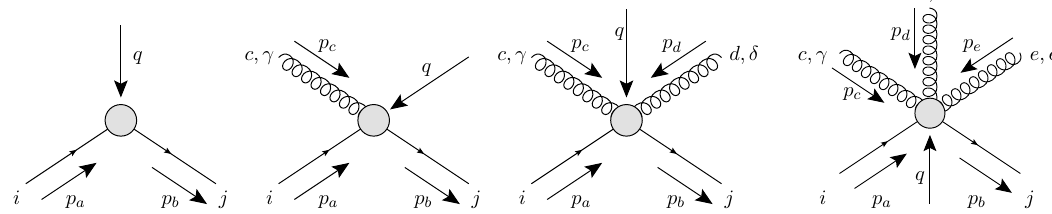
Figure 2 . Quark two-point and quark-gluon three-, four-, and (cid:12)ve-point functions with momentum insertion into the operator.